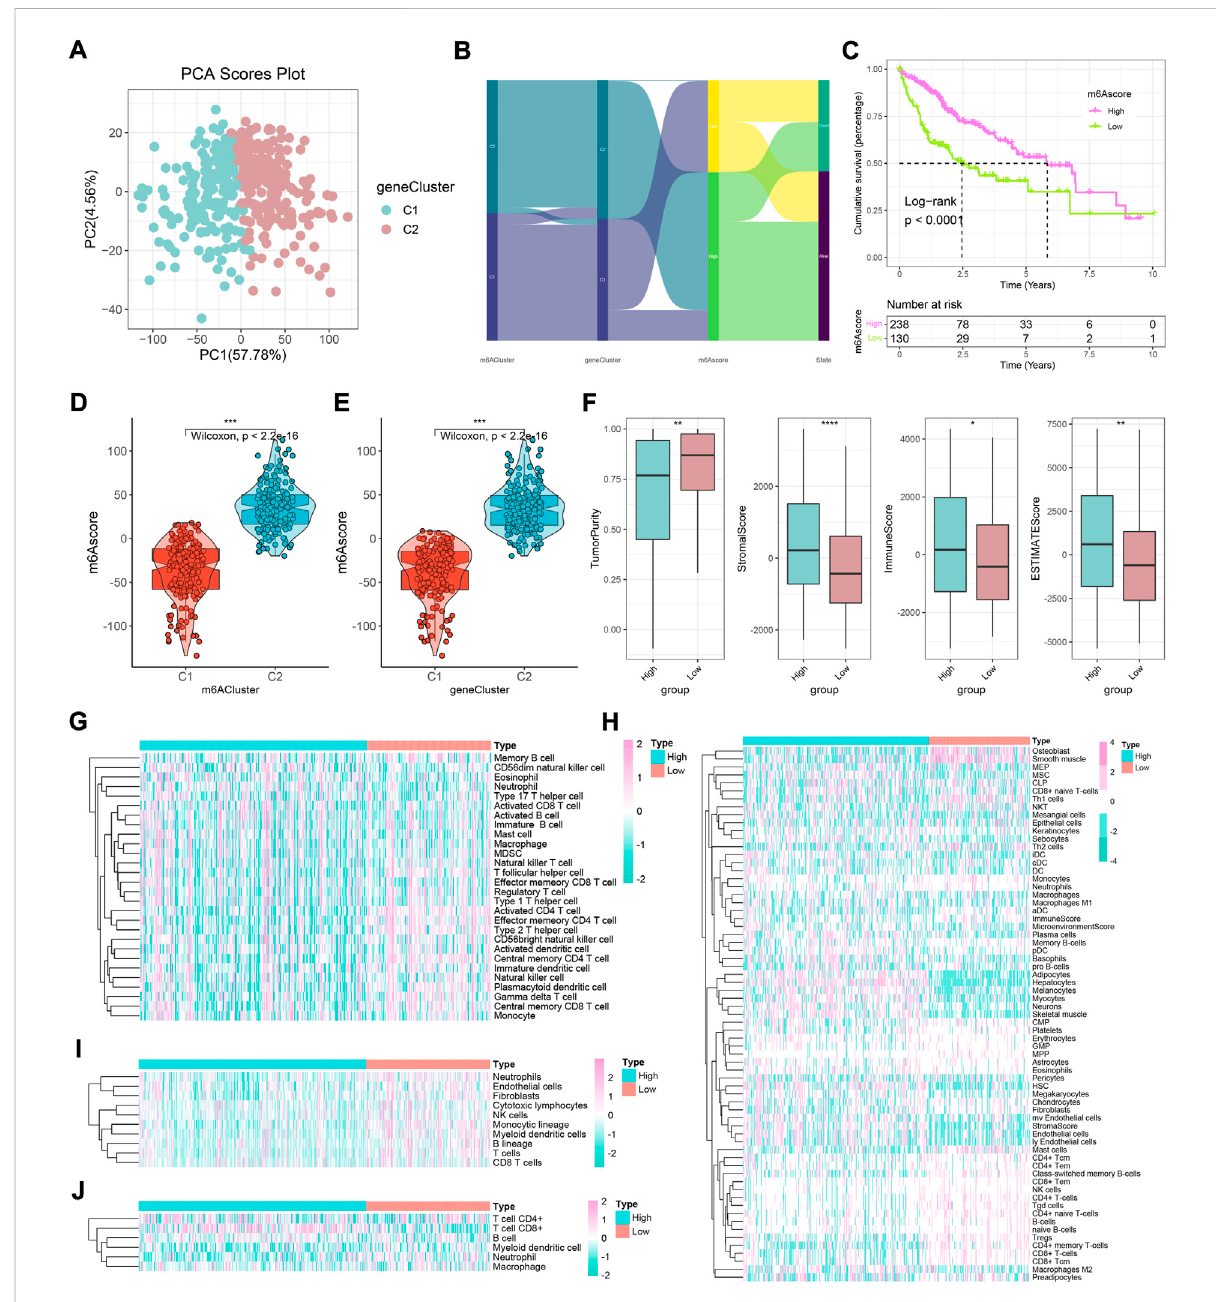
FIGURE 5 Construction of an m6A gene signature and exploration of its clinical signi fi cance in HCC. (A) Two gene clusters by principal component analysis. (B) Sankey diagram showing thechanges in m6A clusters, gene clusters, m6Ascore, and survival status. (C) Survival outcomes ofpatients by m6Ascore. The survival outcomes of patients in the low-m6Ascore group are better. (D) Variation analysis of m6Ascore between m6A clusters. (E) Variation analysis of m6Ascore between gene clusters. (F) Difference in ESTIMATE, immune, stromal, and tumor purity scores between high- and low-m6Ascore groups based on ESTIMATE algorithm (* p < 0.05, ** p < 0.01, *** p < 0.001, **** p < 0.0001, and ns, not signi fi cant). (G – J) Heatmapsofimmune cell in fi ltration inhigh- andlow-m6Ascore groups basedon ssGSEA, xCell,MCP-counter, andTIMER algorithms,